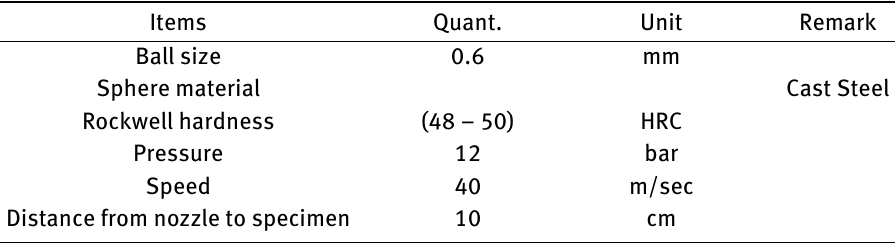
Table 1: Specifications of shot peening machine